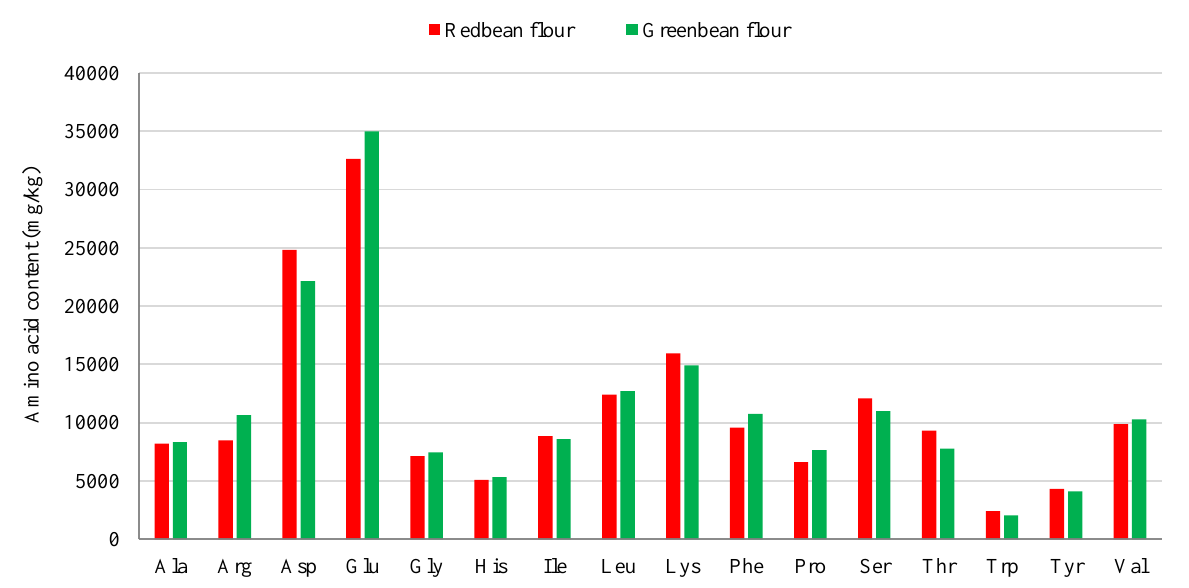
Figure 1. Amino acid analysis results (mg/kg) on red beans flour and green beans